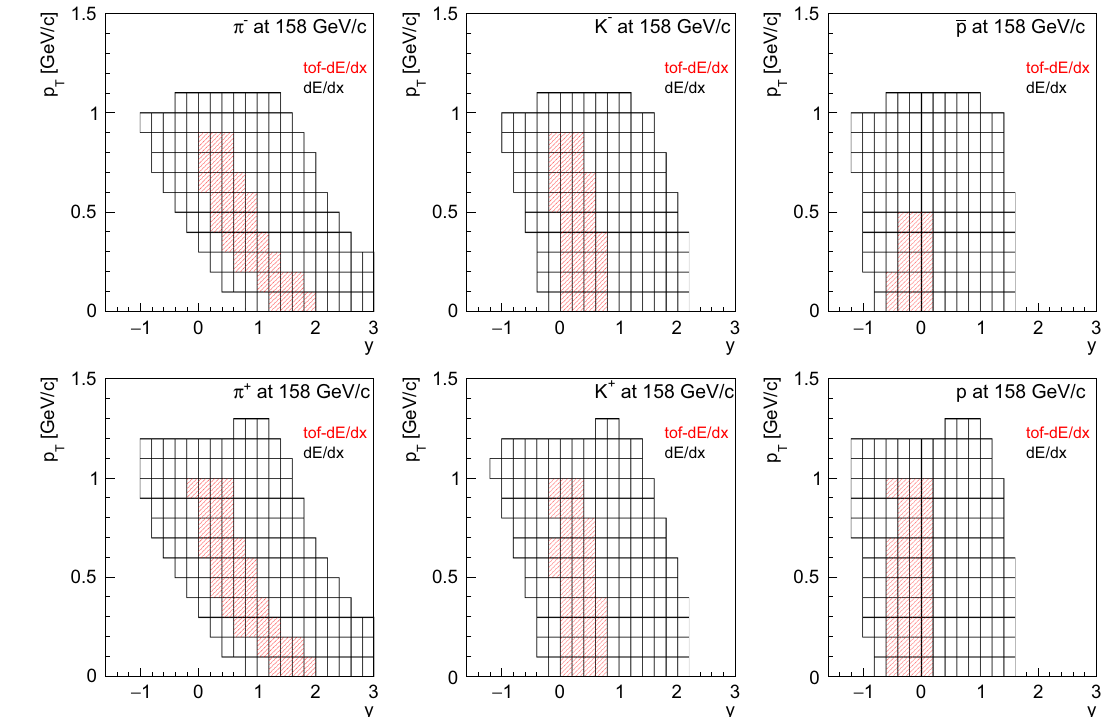
Fig. 3 Acceptance of the tof -d E / d x and d E / d x methods for identification of pions, kaons and protons in p + p interactions at 158 GeV / c Fig. 4 Distribution of charged particles in the d E / d x - q × p lab plane. The energy loss in the TPCs for different charged particles for events and tracks selected for the analysis of p + p interactions at 80 GeV / c (the target inserted configuration). Expectations for the dependence of the mean d E / d x on p lab for the considered particle types are shown by the curves calculated based on the Bethe–Bloch